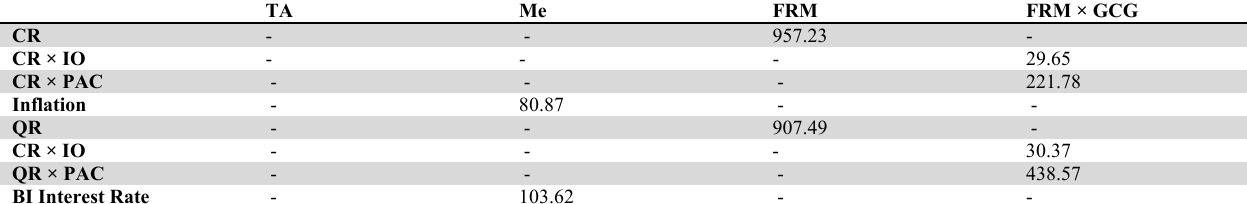
Outer Model Testing